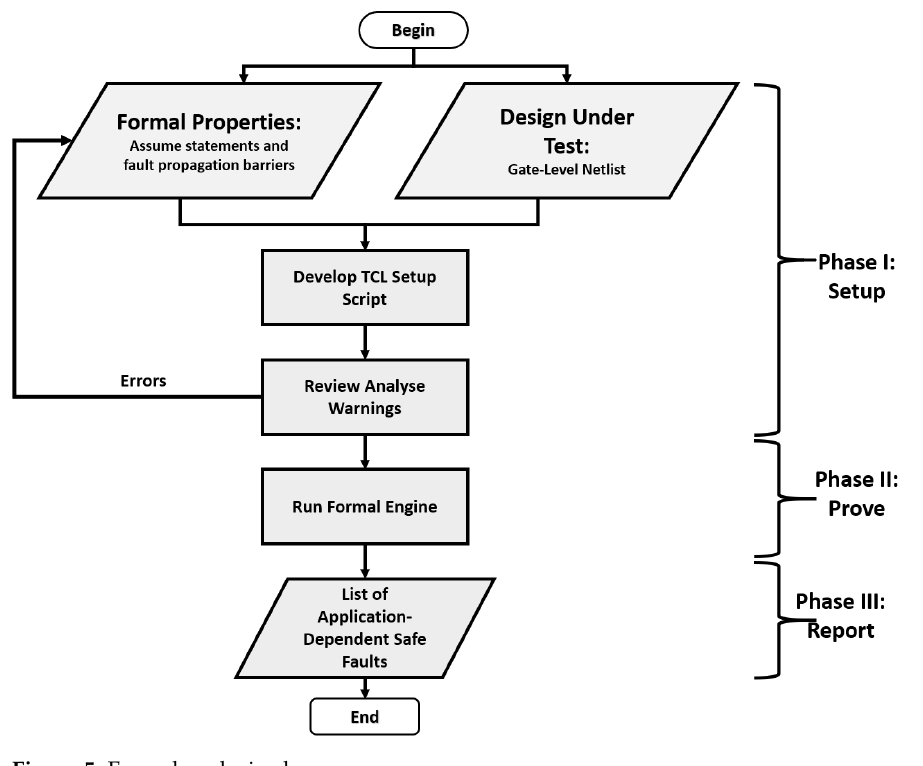
Figure 5. Formal analysis